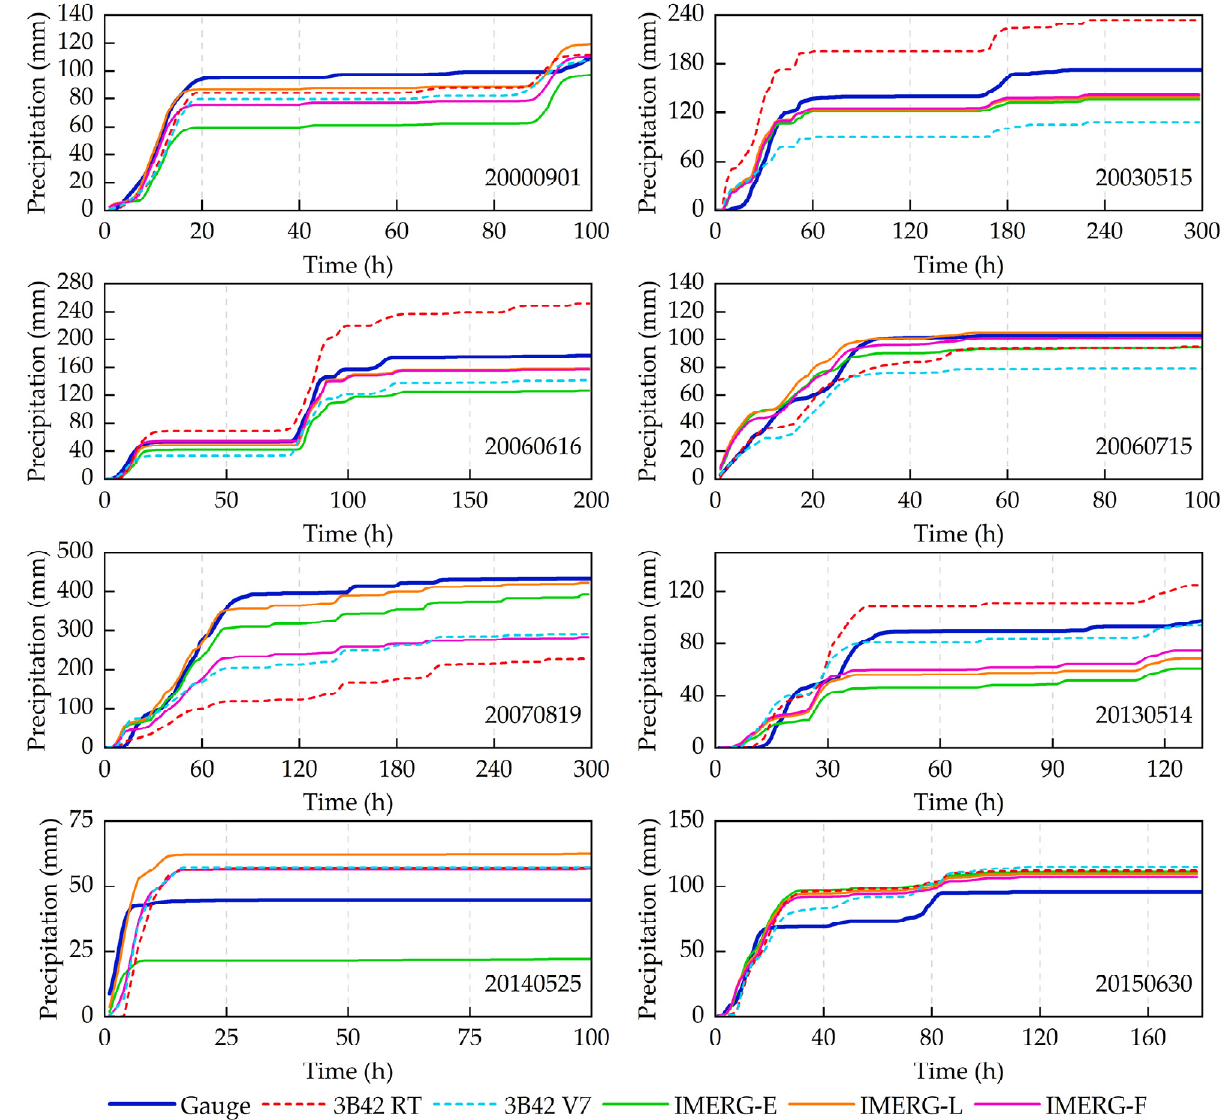
Figure 5. Comparison of the cumulative precipitation between gauge precipitation and the five SPPs of the eight historical flood events in 2000–2015 at the Ganxi hydrological station.